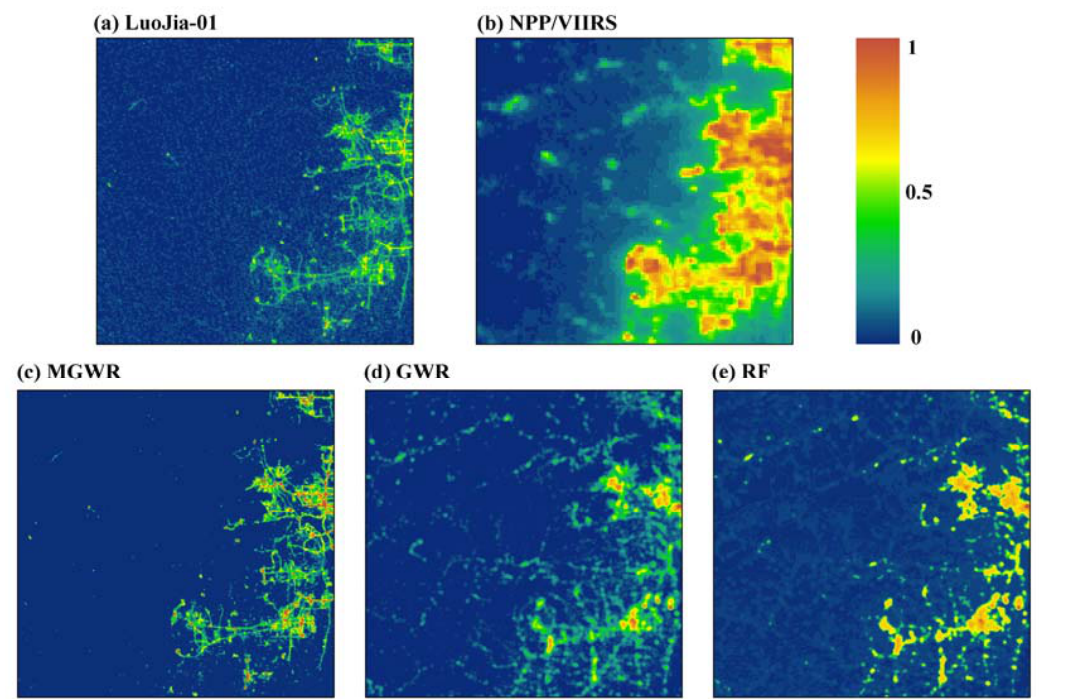
Figure 8. Spatial images comparing results of the three downscaling methods in the FS region, ( a ) LuoJia-01, ( b ) NPP/VIIRS, ( c ) MGWR, ( d ) GWR, ( e ) RF. (Spatial resolution: 500 m; study period: September 2018).